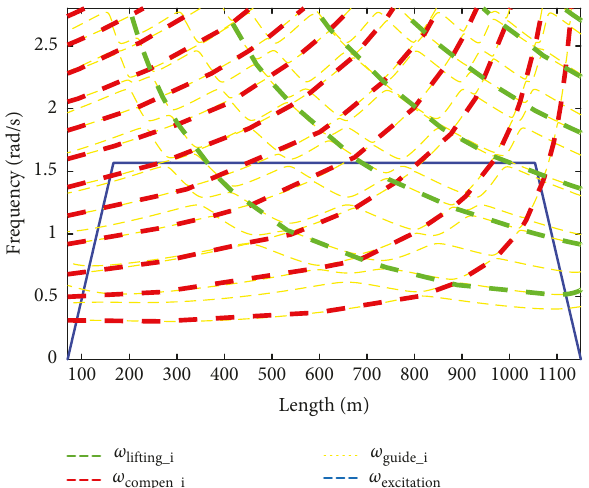
Figure 23: Natural frequencies of the lifting, compensating, and guiding ropes.